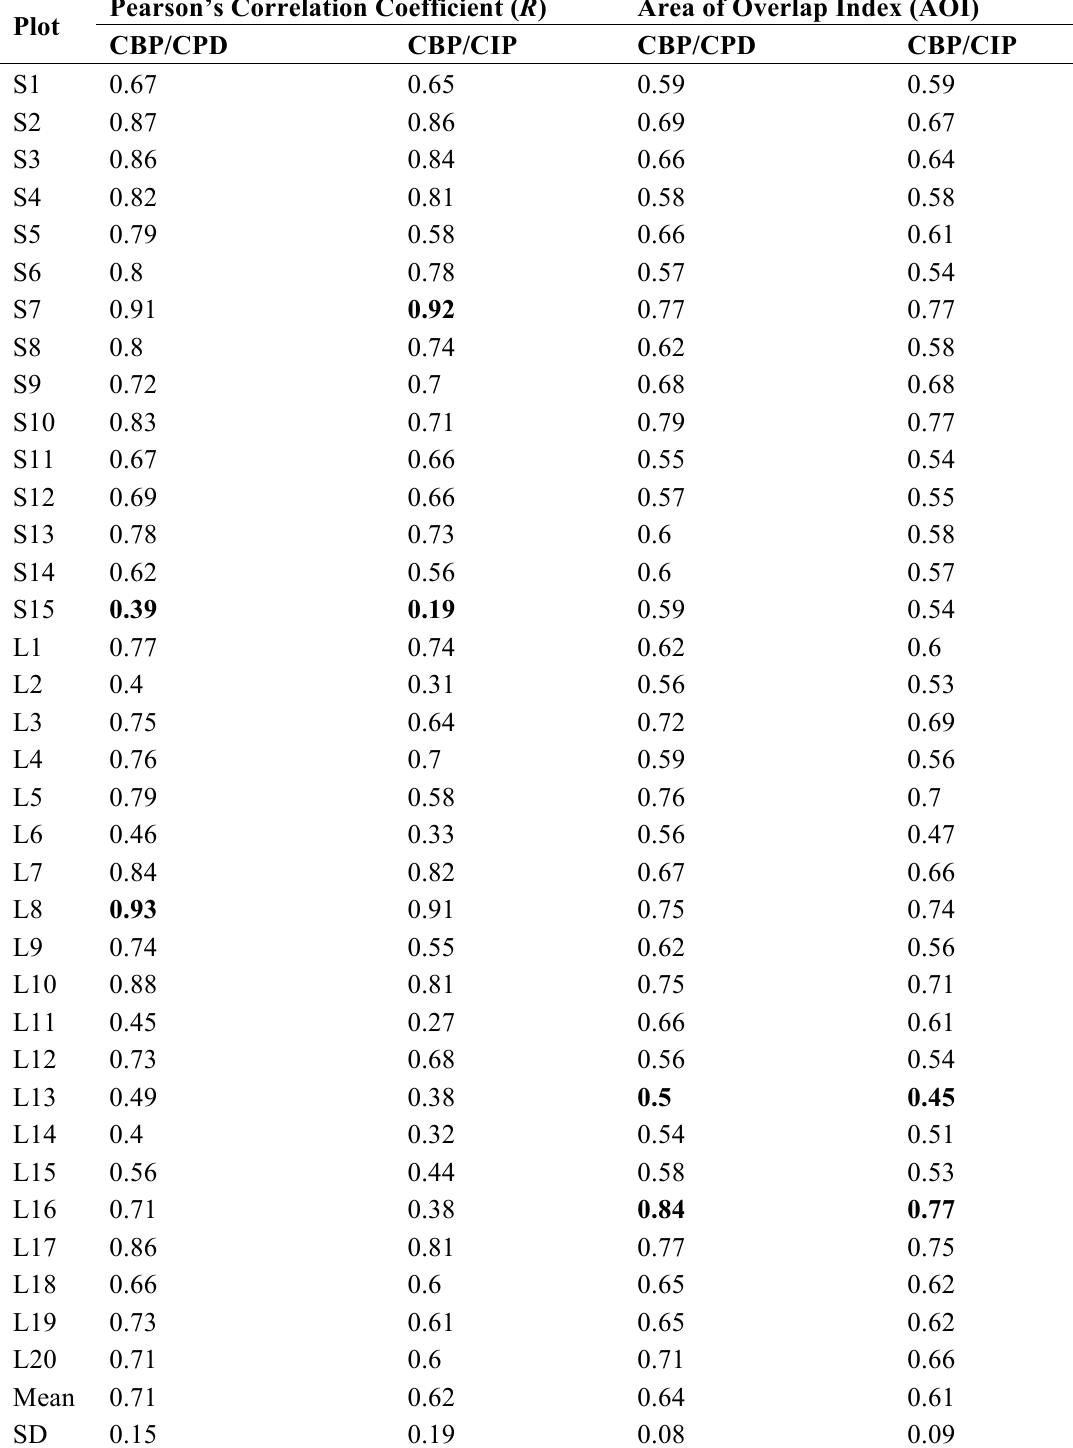
Table 6. Correlation between different pairs of vertical